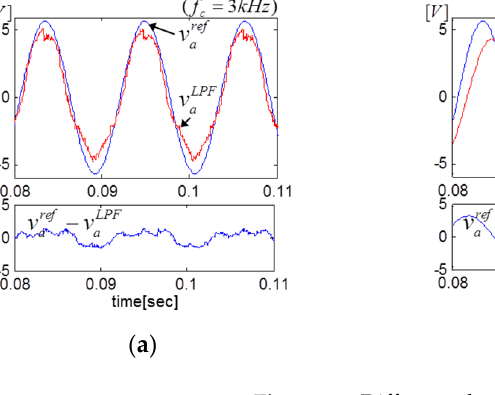
(LPF) with a 3 kHz cut-off frequency; ( b ) LPF with a 0.3 kHz cut-off frequency; and ( c ) extended